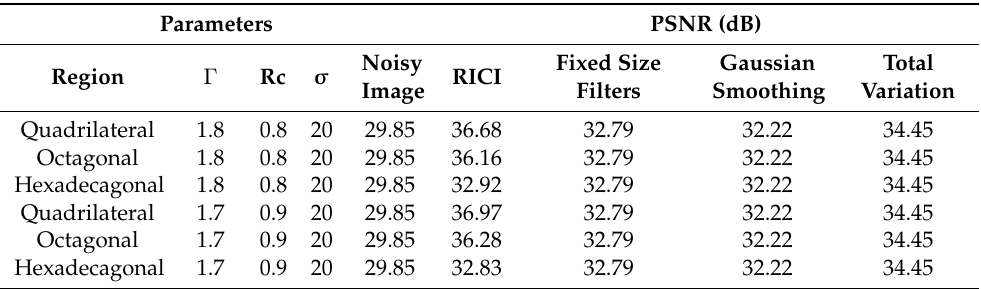
Figure 5. Ankle X-ray scan. ( a ) Original noise-free image; ( b ) Noisy image (AWGN with σ = 25); ( c ) Image denoised using the 2D LPA-RICI method (quadrilateral region, Г = 1.8, Rc = 0.8); ( d ) Image denoised using the 2D LPA-RICI method (octagonal region, Г = 1.8, Rc = 0.8); ( e ) Image denoised using the 2D LPA-RICI method (hexadecagonal region, Г = 1.8, Rc = 0.8); ( f ) Image denoised using Gaussian smoothing filters; ( g ) Image denoised using total variation denoising. Table 5. PSNRs for ankle X-ray images denoised using the proposed 2D LPA-RICI method and the competitive